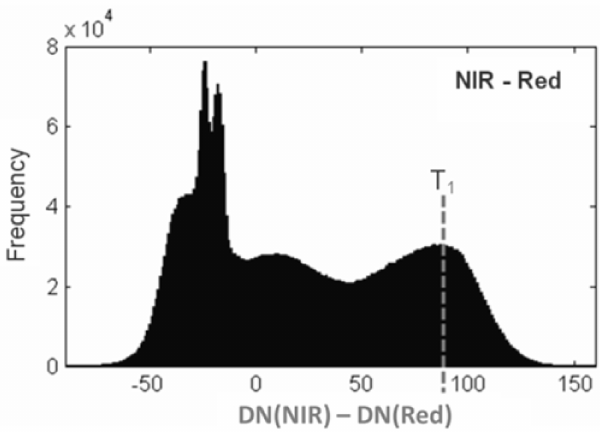
Figure 11. Histogram thresholding of digital number (DN) differences of the NIR and red bands (e.g., image ETM+ of 8 June 2001) for the detection of dense forest dark